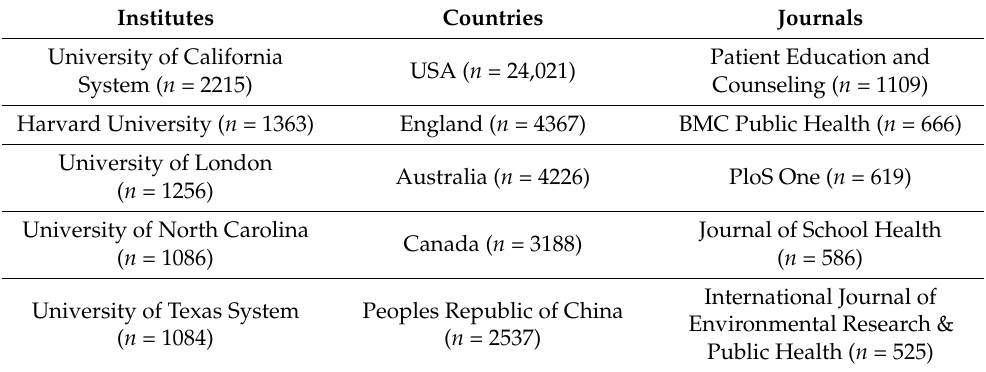
Table 2. Top-five stakeholders in patient education research.